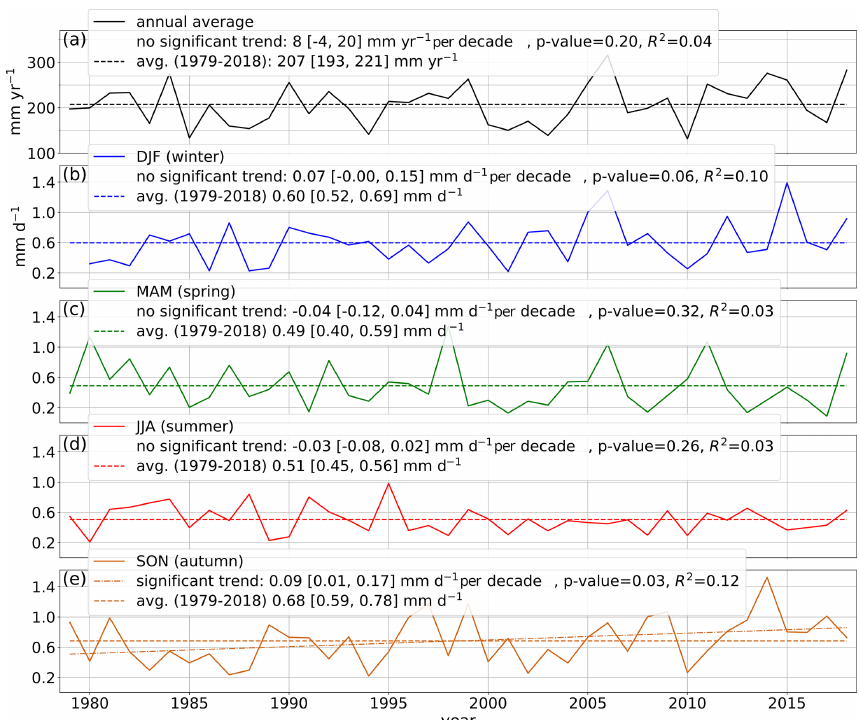
Figure 13. (a) Annual and (b–e) seasonal temporal evolution of precipitation amount in the study region from ERA-Interim with estimates of a possible linear trend and its corresponding p values. In autumn (SON), the existence of a positive upward linear trend can not be rejected under the 6%